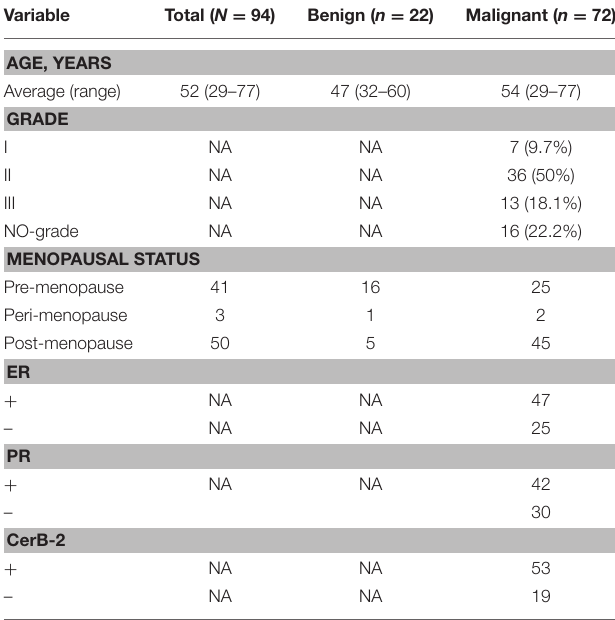
TABLE 1 | Demographic information of all subjects used in this